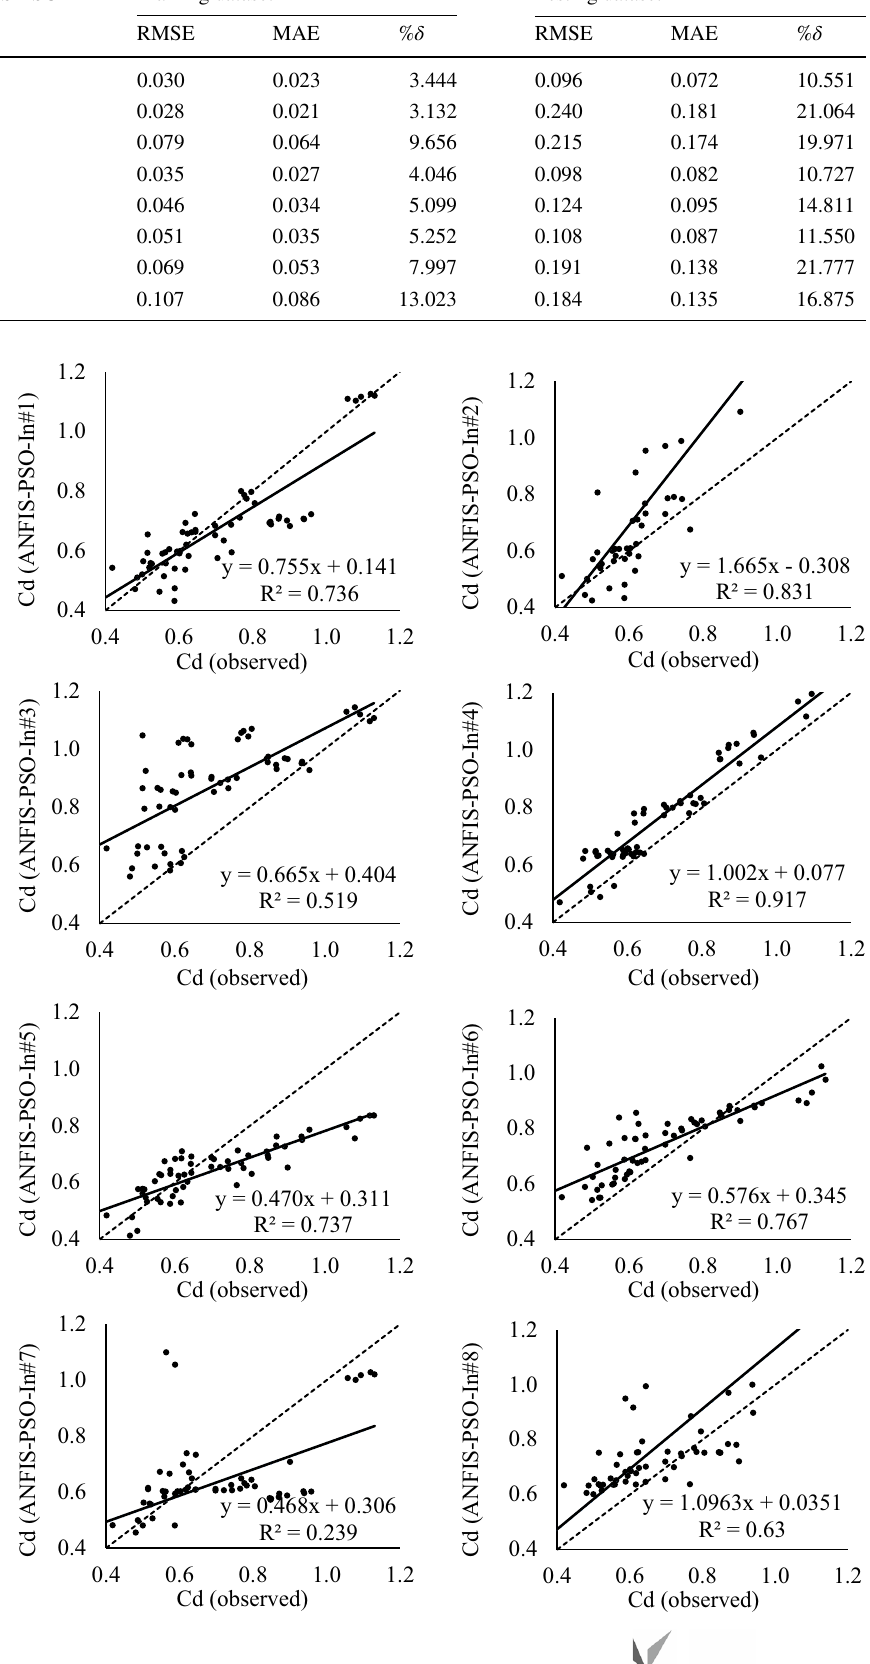
performance evaluation for various input combinations